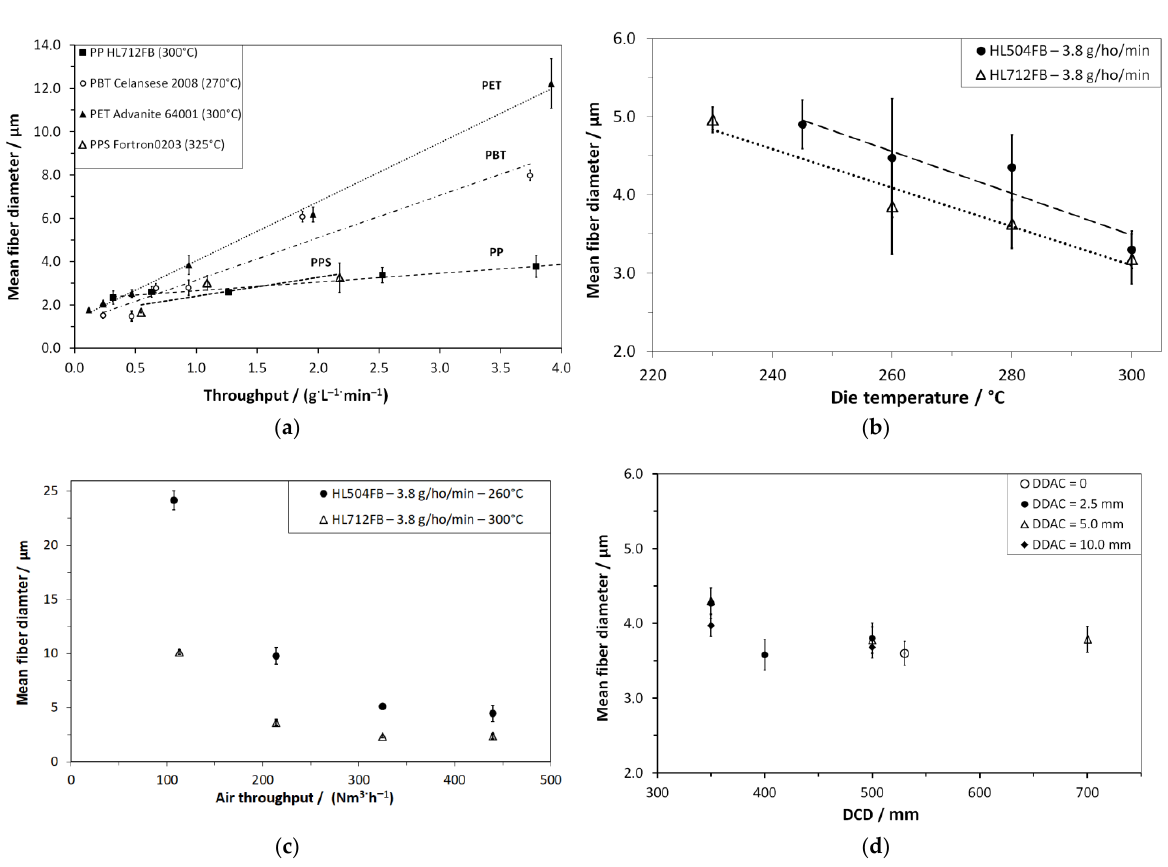
. V = 3.8 g · ho − 1 · min − 1 ); . V = 3.8 g · ho − 1 · min − 1 , V air = 220 Nm3 · h − 1 )